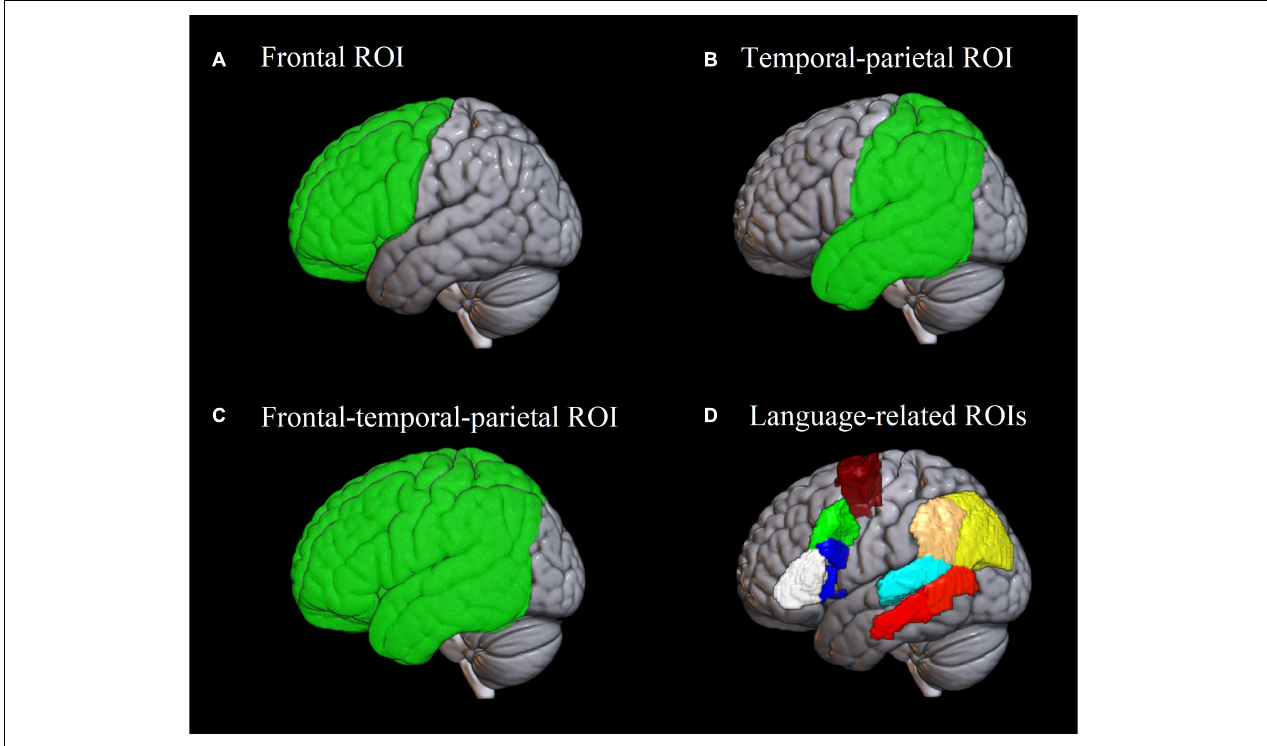
FIGURE 2 | Regions of interest used in the analysis. (A–C) Frontal, temporal-parietal and frontal-temporal-parietal region of interest used in the analysis of Dice coefficients and lateralization indices. (D) Eight language-related regions of interest based on the Brainnetome atlas (Fan et al., 2016) implemented in the ICN_atlas toolbox (Kozák et al., 2017), used for assessing individual-level activation. White: pars triangularis of the inferior frontal gyrus; blue: pars opercularis of the inferior frontal gyrus; green: posterior middle frontal gyrus; burgundy: supplementary motor area; red: posterior middle temporal gyrus; cyan: posterior superior temporal gyrus; beige: supramarginal gyrus; yellow: angular gyrus.